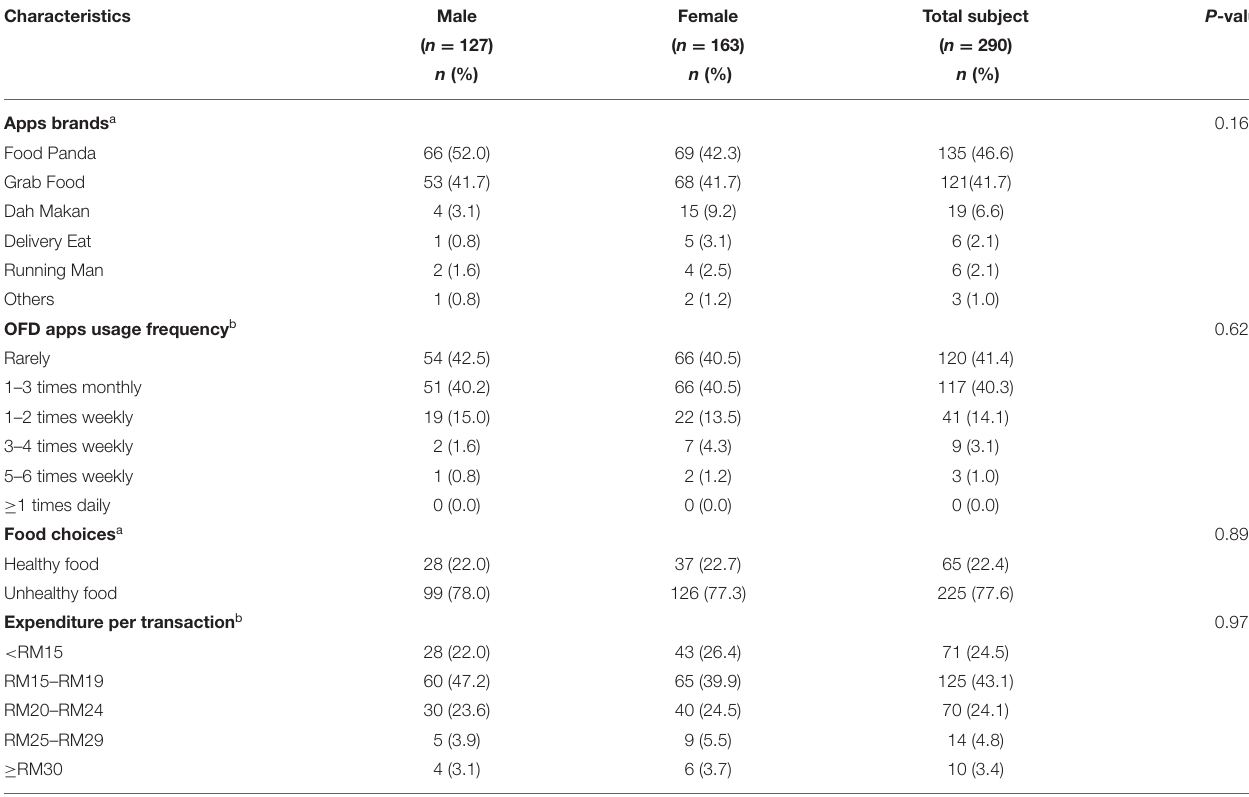
TABLE 3 | Use of OFD apps.